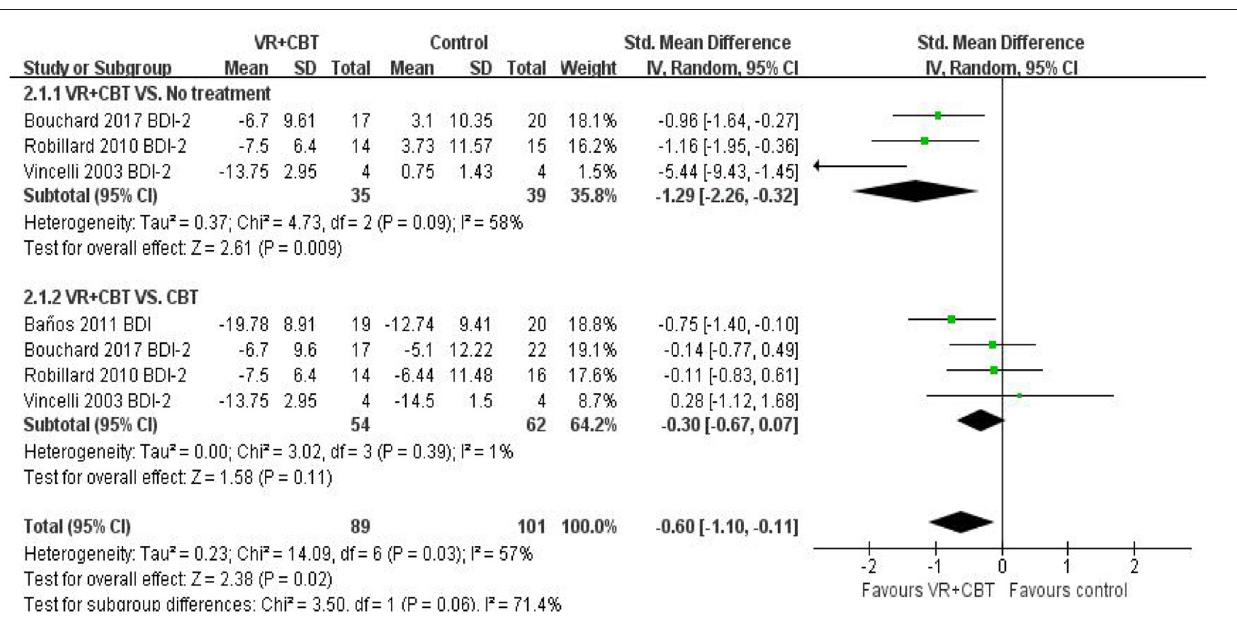
FIGURE 4 | Forest plot of VRCBT vs. no treatment or CBT comparators for depression severity.